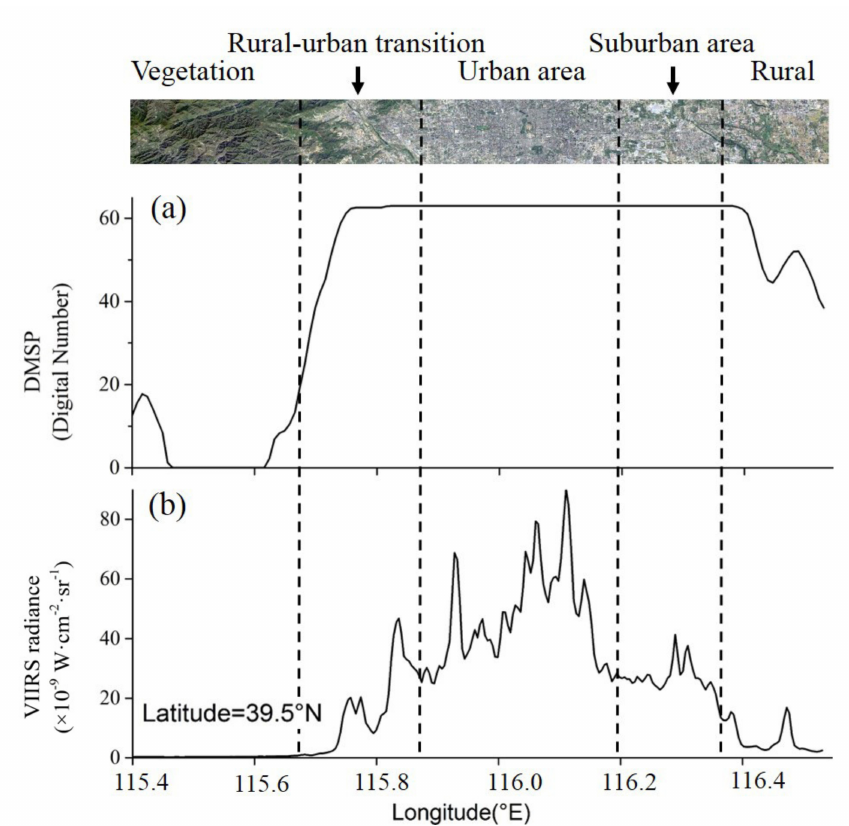
Figure 9. The profile of the nighttime light data in Beijing city. (( a ) DMSP/OLS (defense meteorological satellite program’s operational linescan system) nighttime light data; ( b ) Suomi-NPP VIIRS (Suomi national polar-orbiting partnership visible infrared imaging radiometer suite) nighttime light